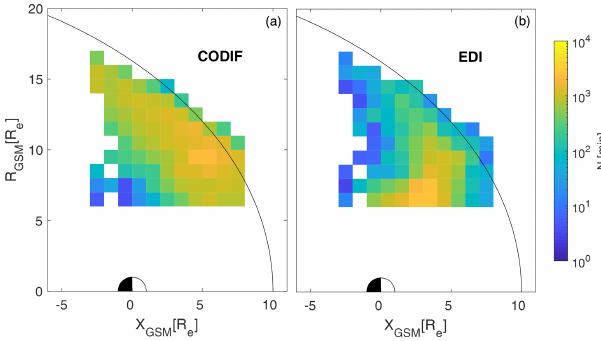
Figure 2. Coverage of CODIF and EDI data projected into the Northern Hemisphere. The data are represented in a cylindrical co- ordinate system, where R GSM = indicates the number of 1min measurements in each 1 × 1 R E bin. Panel (a) depicts CODIF coverage, while panel (b) depicts EDI cov-